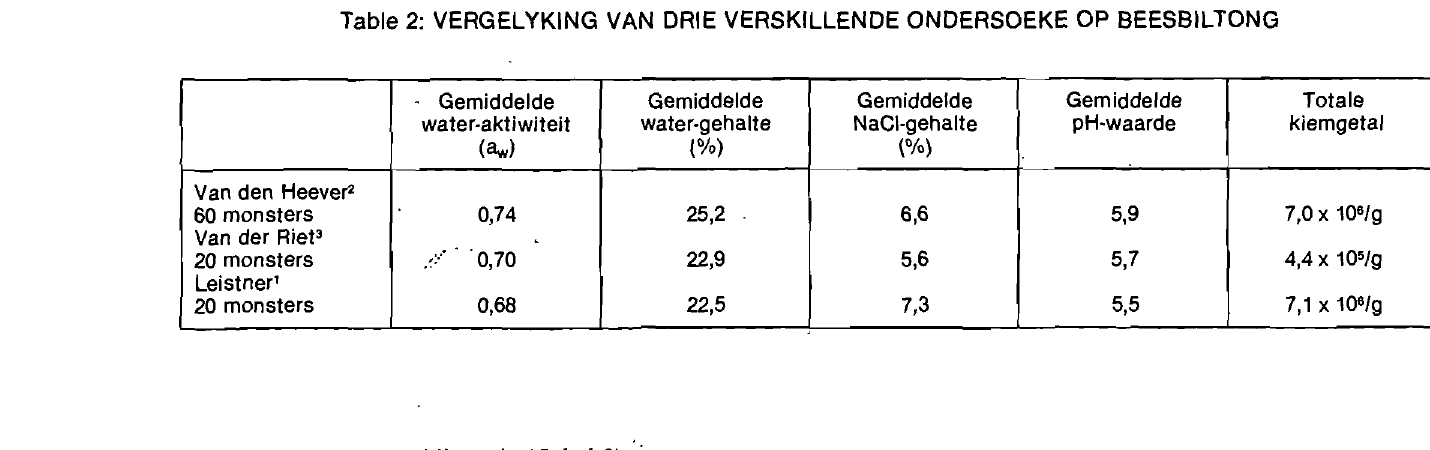
Table 2: VEAGELYKING VAN DAlE VEASKILLENDE ONDEASOEKE OP